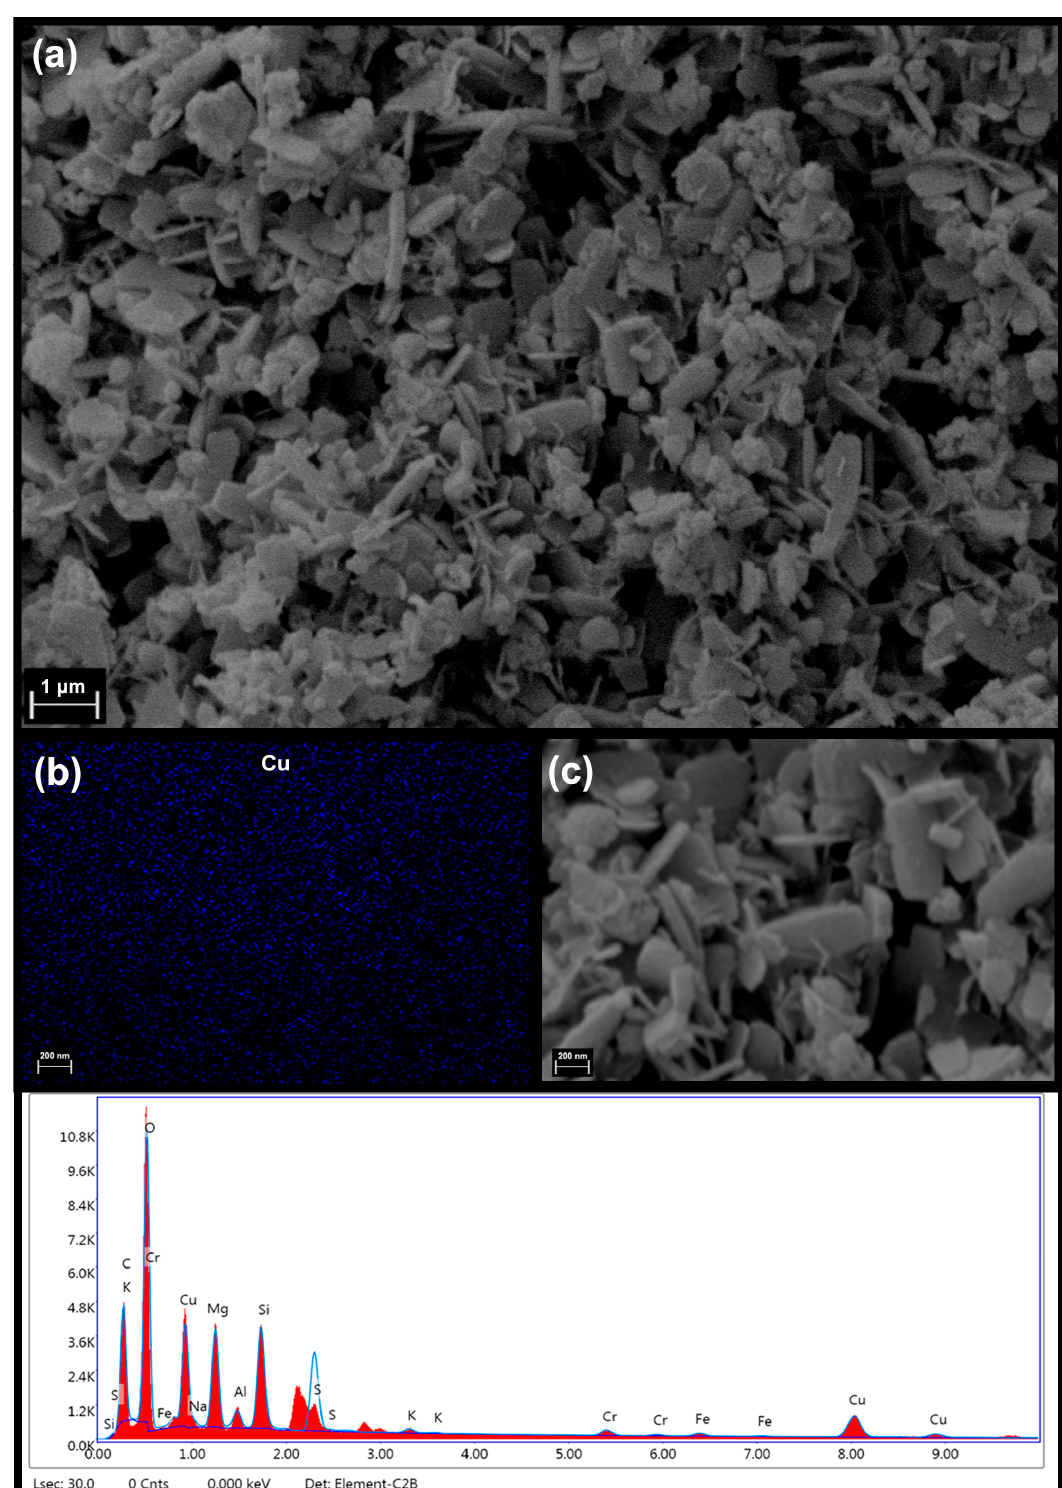
Figure 3. SEM micrograph ( a ) at 20k magnification, ( b ) EDS analysis, and ( c ) SEM micrograph at 75k magnification of 4 g/L WGFCA after 300 min of adsorption with 1000 mg/L initial metal concentration.